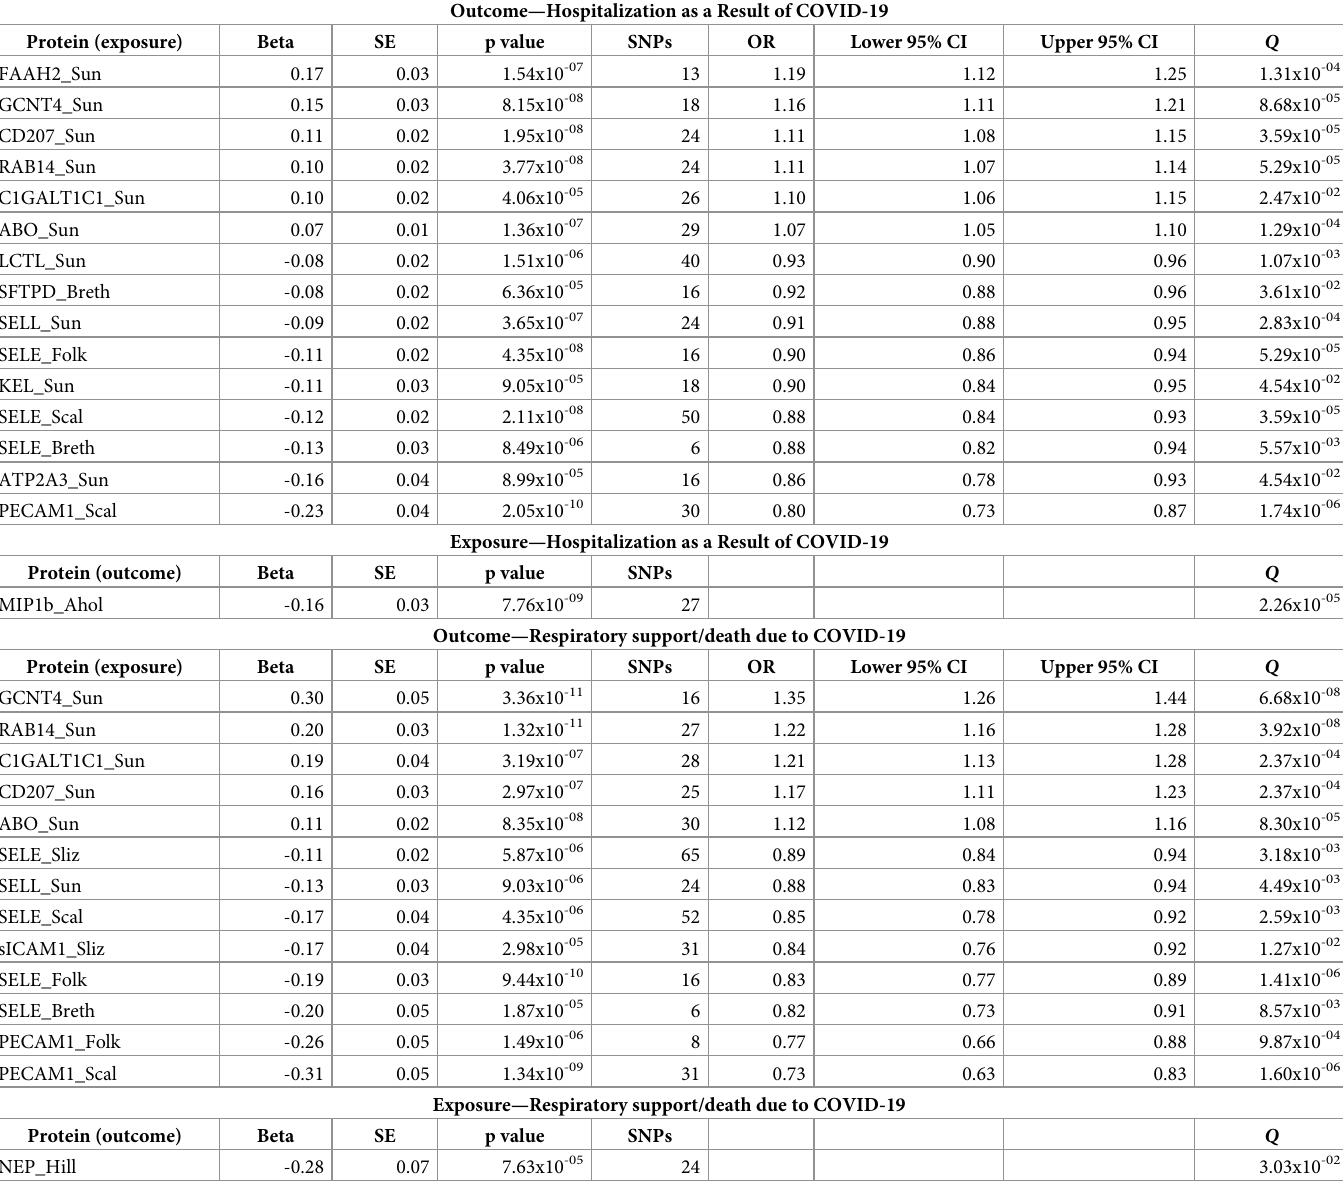
Table 1. Mendelian randomization results with COVID-19. Details of significant, false discovery rate-(FDR)-corrected Mendelian randomization results, using the Generalized Summary Data-based Mendelian randomization (GSMR) method. Using genetic instruments and under the assumptions of Mendelian randomization, the top section shows results consistent with six blood markers being significantly causally associated with an increased risk of hospitalization as a result of COVID-19 and the nine blood markers causally associated with a decreased risk of hospitalization, as well as one protein showing a decrease in risk of hospitalization. The bottom section shows results consistent with five blood markers being significantly causally associated with an increased risk for the need of respiratory support/death due to COVID-19 and eight blood markers causally associated with a decreased risk for the need of respiratory support/death due to COVID-19, as well as one protein decreasing risk for the need of respiratory support/death due to COVID-19. The table presents the log odds statistics (i.e., beta) and corresponding standard error as well as odds ratios, 95% con- fidence intervals, and the FDR-adjusted Q values (p FDR =